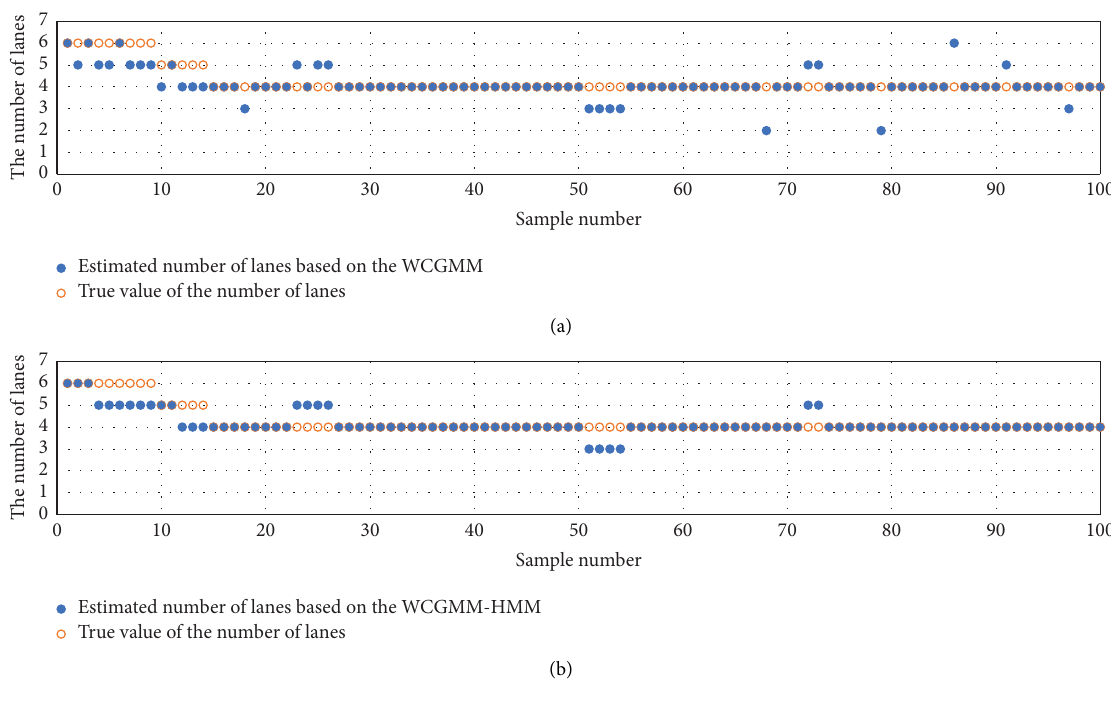
Figure 14: Te number of actual lanes and the number of extracted lanes on multiple consecutive road cross sections: (a) estimated results based on the WCGMM; (b) estimated results based on the WCGMM and HMM.